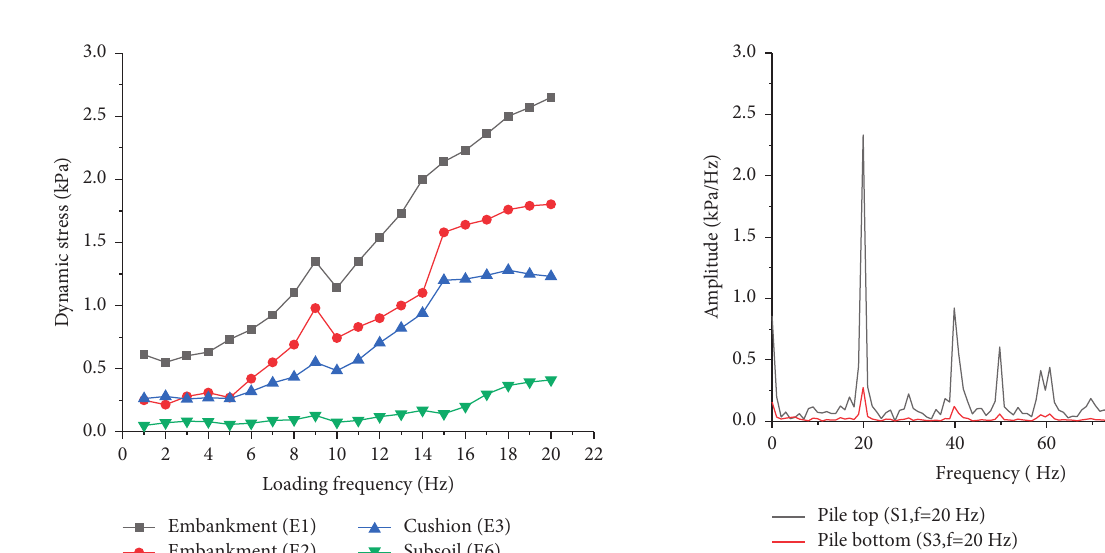
Figure 17: Relation between dynamic soil stress and loading frequency in the track substructure.